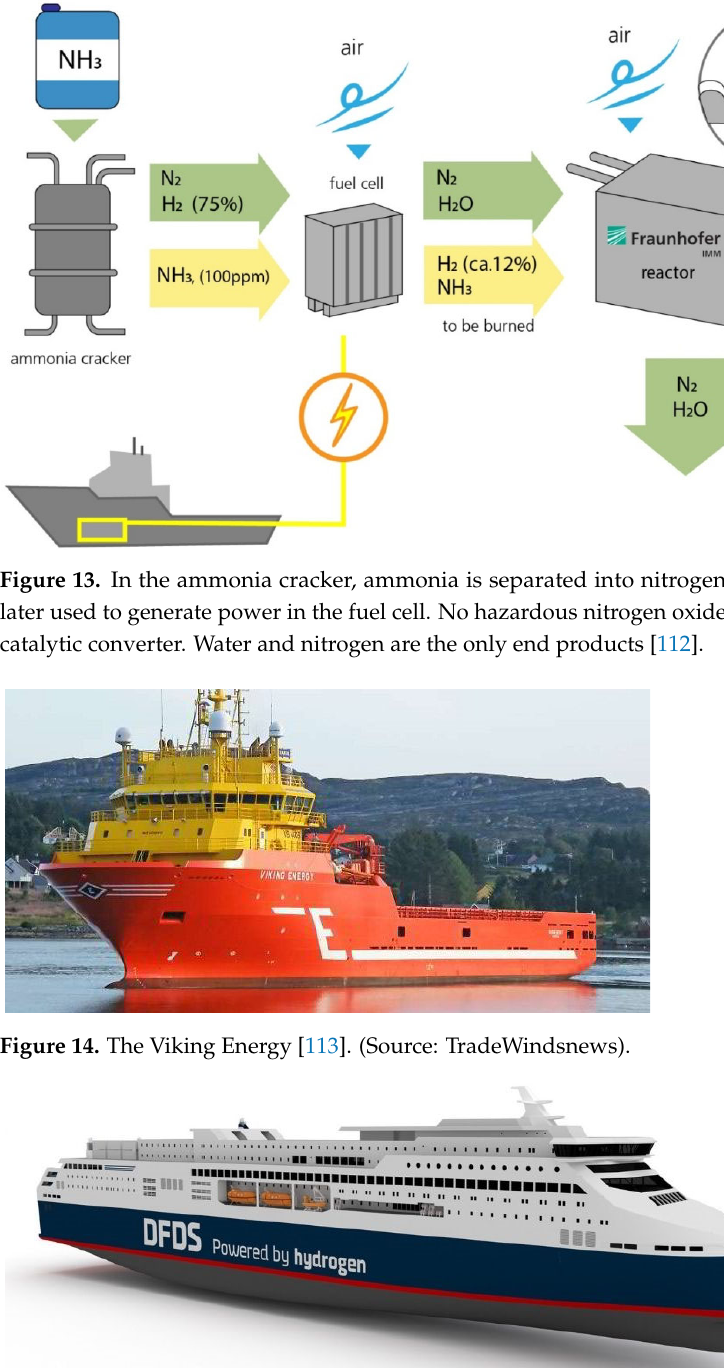
Figure 14. The Viking Energy [113]. (Source: TradeWindsnews).